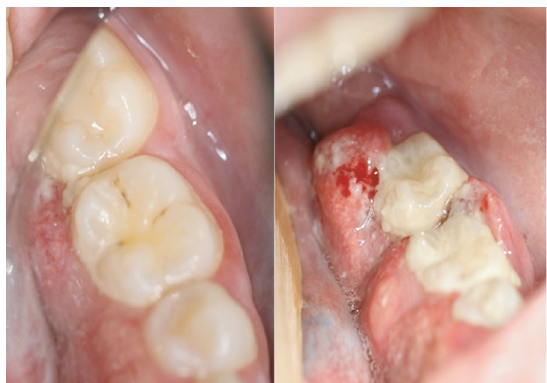
Figure 1: The patient at presentation/biopsy appointment (a) and one month later, before surgery (b). A marked enlargement of the tumor area is shown, with extension to the buccal side of the molar teeth. Plaque accumulation is also detected, owing to pain during brushing. Clinical photography proved di ffi cult due to pain and discomfort a ff ecting the area.